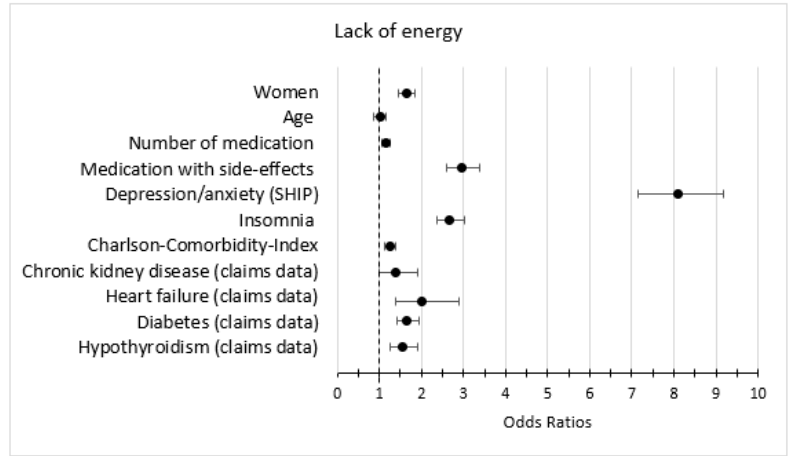
Figure 4. Bivariate logistic regression models (anemia + second variable) with the outcome lack of energy; only the estimates (odds ratios and 95% confidence intervals) of the second variable is shown (weighted) .